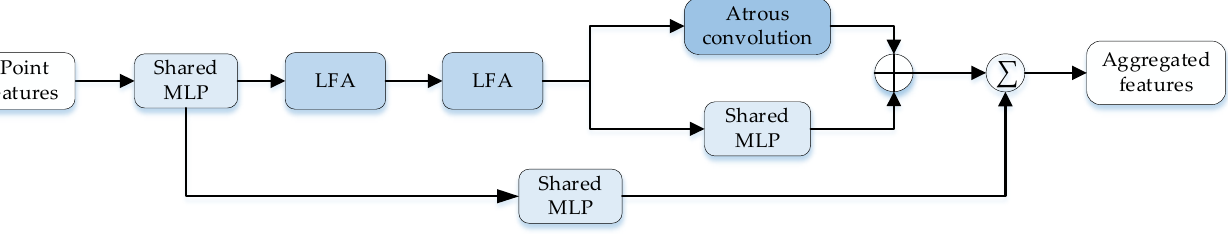
Figure 2. Fusion atrous convolution residual module.